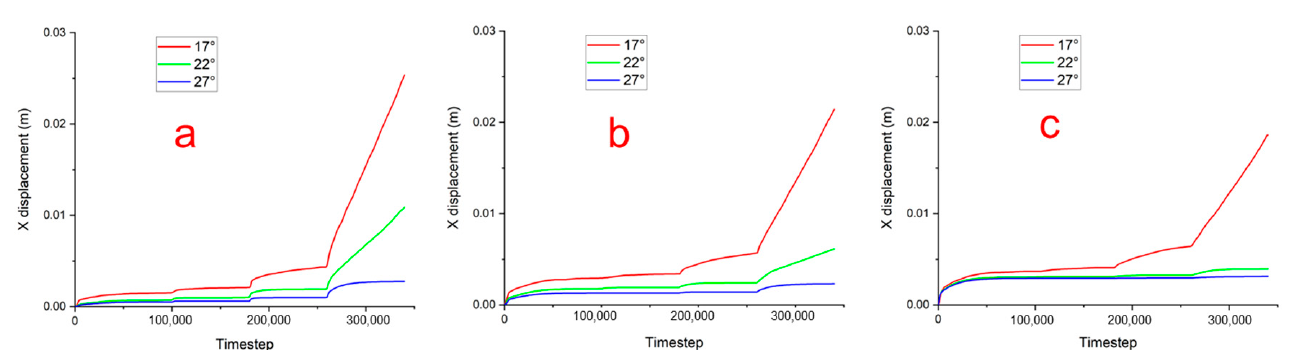
Figure 17. Sensitivity analysis of S0 friction angle by varying from 17° to 27°, showing the displace- ment of history points in X direction ( a ) H1, ( b ) H2 and ( c ) H3.